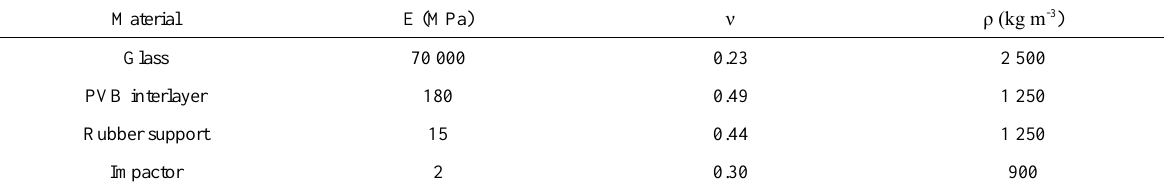
Table 1: Material parameters (Belis (2005), Persson and Doepker (2009), EN